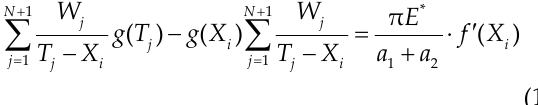
200 GPa  E , 0.3   ; 1 1